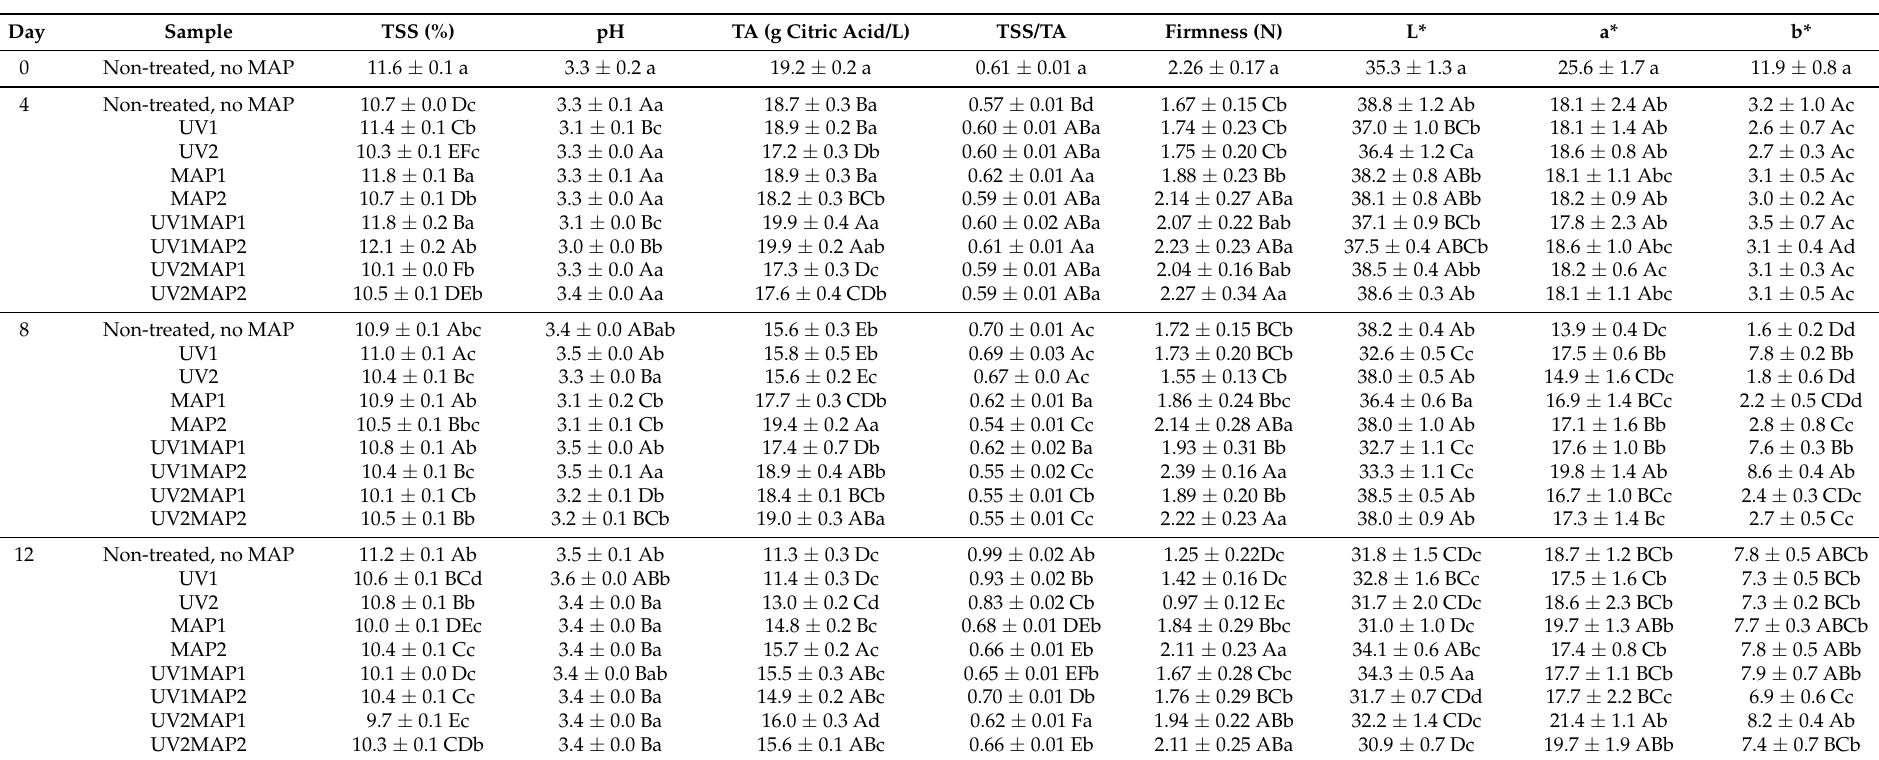
Table 1. Influence of UV radiation, modified atmosphere packaging conditions and combined treatments on the physicochemical quality of raspberries during